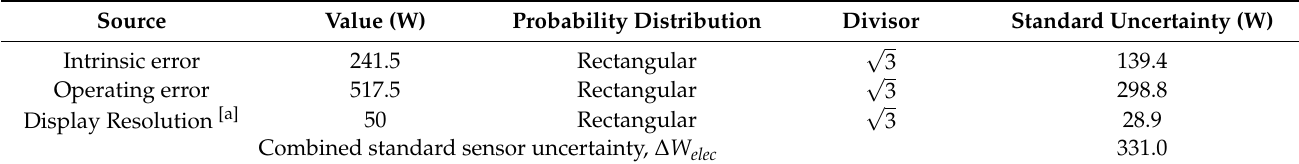
Table 9. Uncertainty budget for electrical energy consumption of the